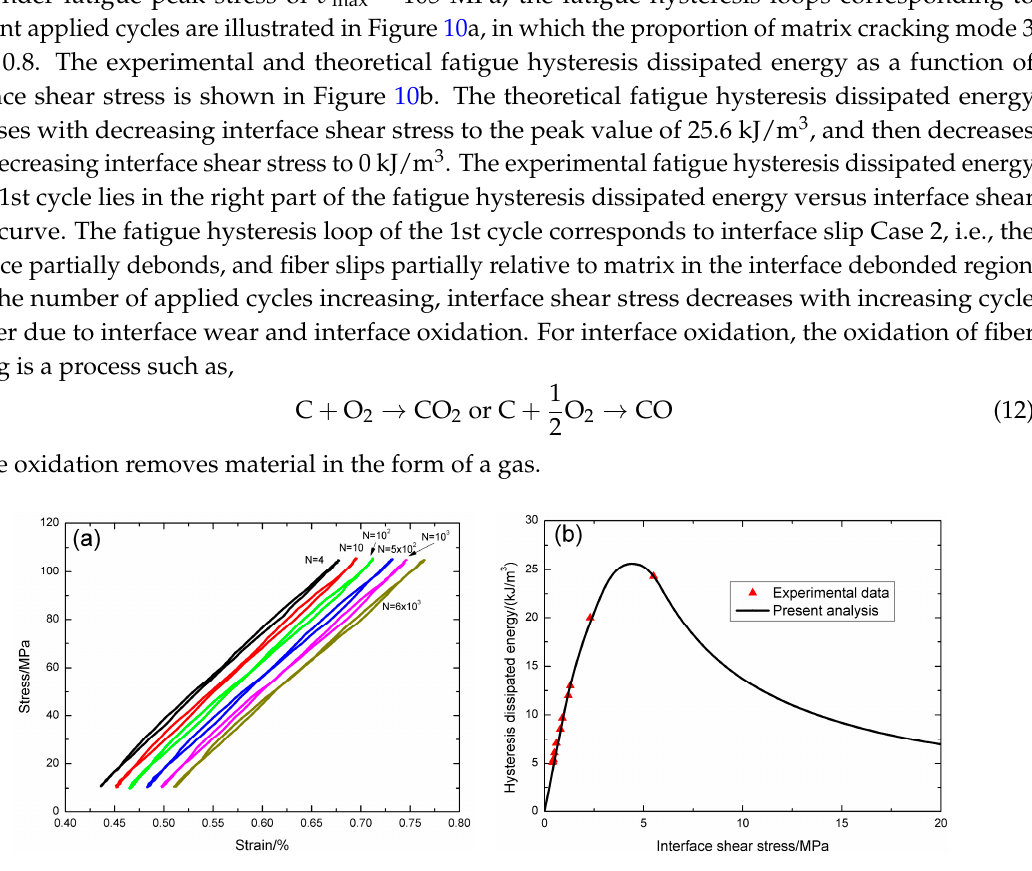
Table 5. The interface shear stress of cross-ply C/SiC composite corresponding to different applied cycles under fatigue peak stress of σ max = 105 MPa at 800 °C in air. Cycle Number